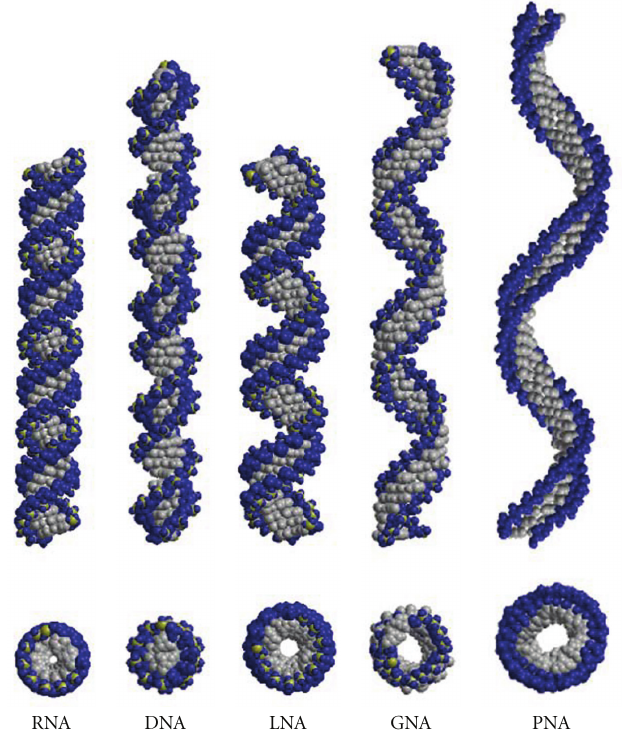
RNA DNA LNA GNA PNA Figure 6: Overall helical structures of natural nucleic acids (RNA and DNA) and of synthetic, modified nucleic acids (LNA, GNA, and PNA). All helices were extended to a total of 46 base pairs. The helices were constructed by using the following structures: DNA (idealized), RNA (idealized), LNA (PDB ID: 2X2Y), GNA (PDB ID: 2JJA), and PNA (PDB ID: 1PUP). Phosphate oxygen atoms are shown in blue, phosphates in yellow, and all other atoms are presented in grey. Top picture shows the side view of the duplexes and the bottom picture presents a projection along the helical